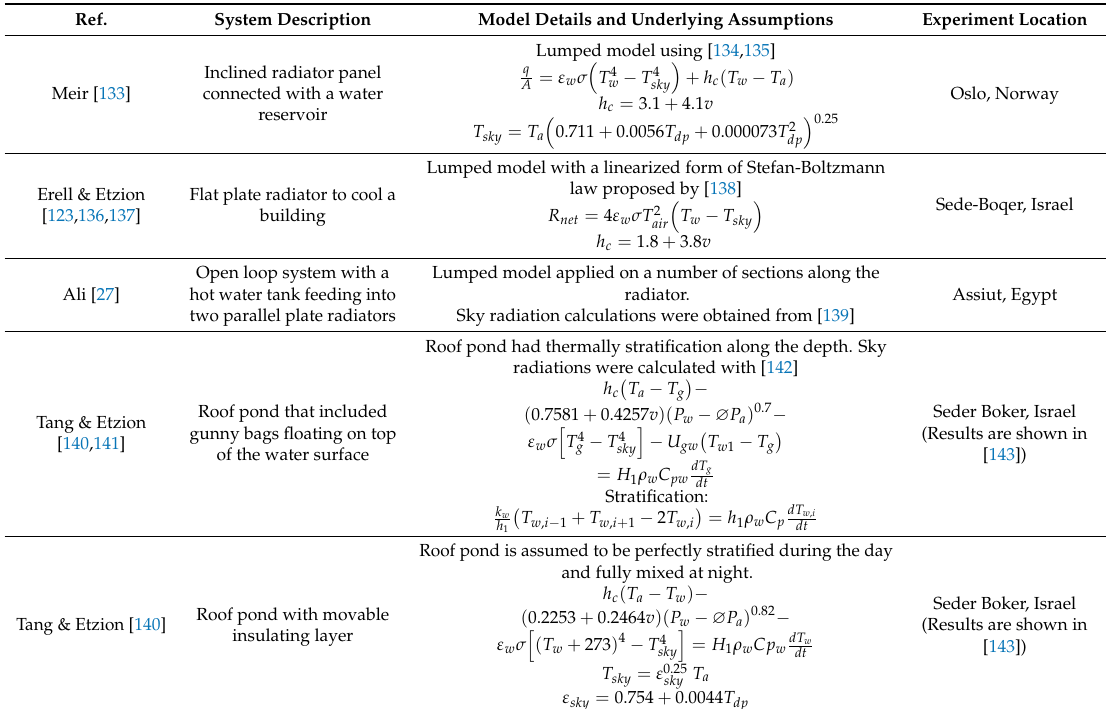
Table 3. List of models proposed for nocturnal